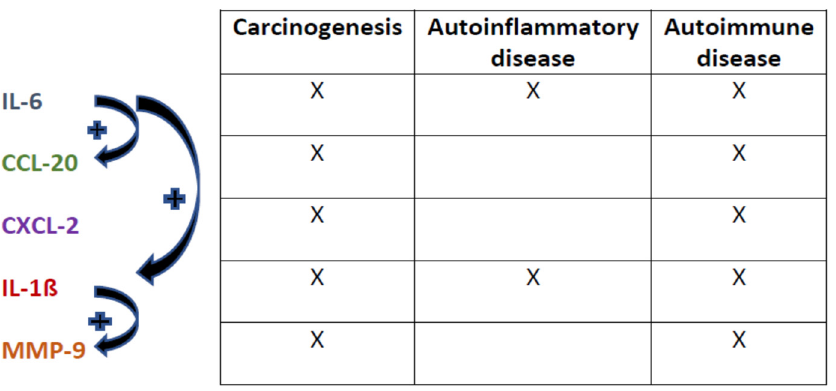
Figure 2. Interaction of IL-1 β , CCL-20, CXCL2, MMP-9 and IL-6 and its effects on carcinogenesis, autoinflammatory disease and autoimmune disease [29,30,37].